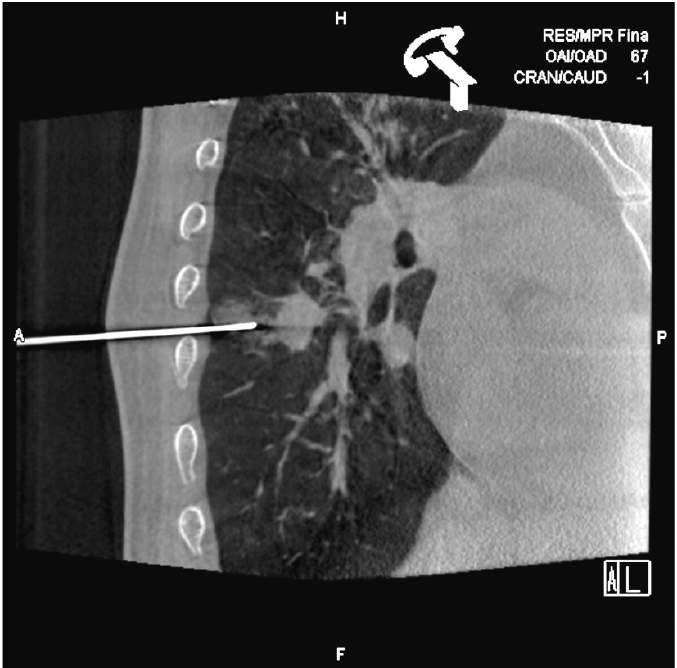
Figure 6. After inserting the coaxial needle, there is already a little hemorrhage observed in the punctured sane lung. We tried to pass the needle through the upper edge of the ribs to avoid the vascular nervous package.